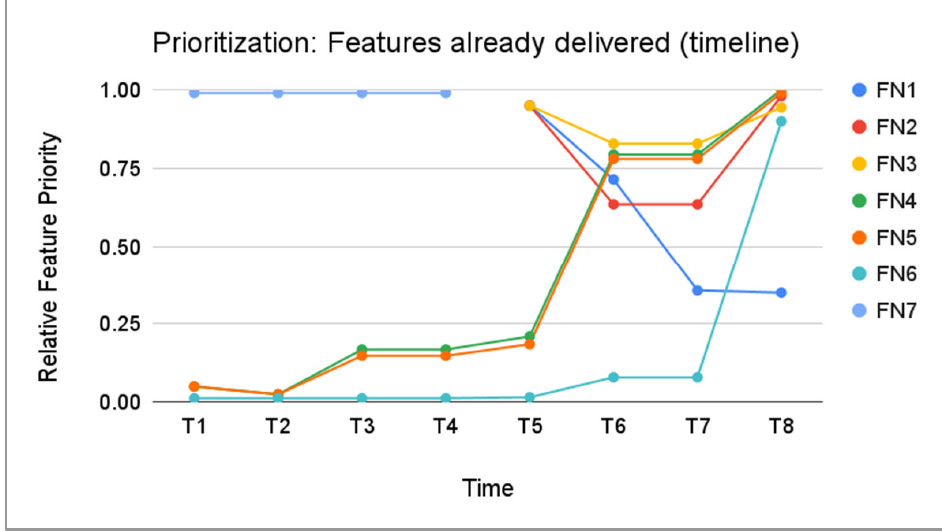
Figure 3. Product roadmap: implemented features.